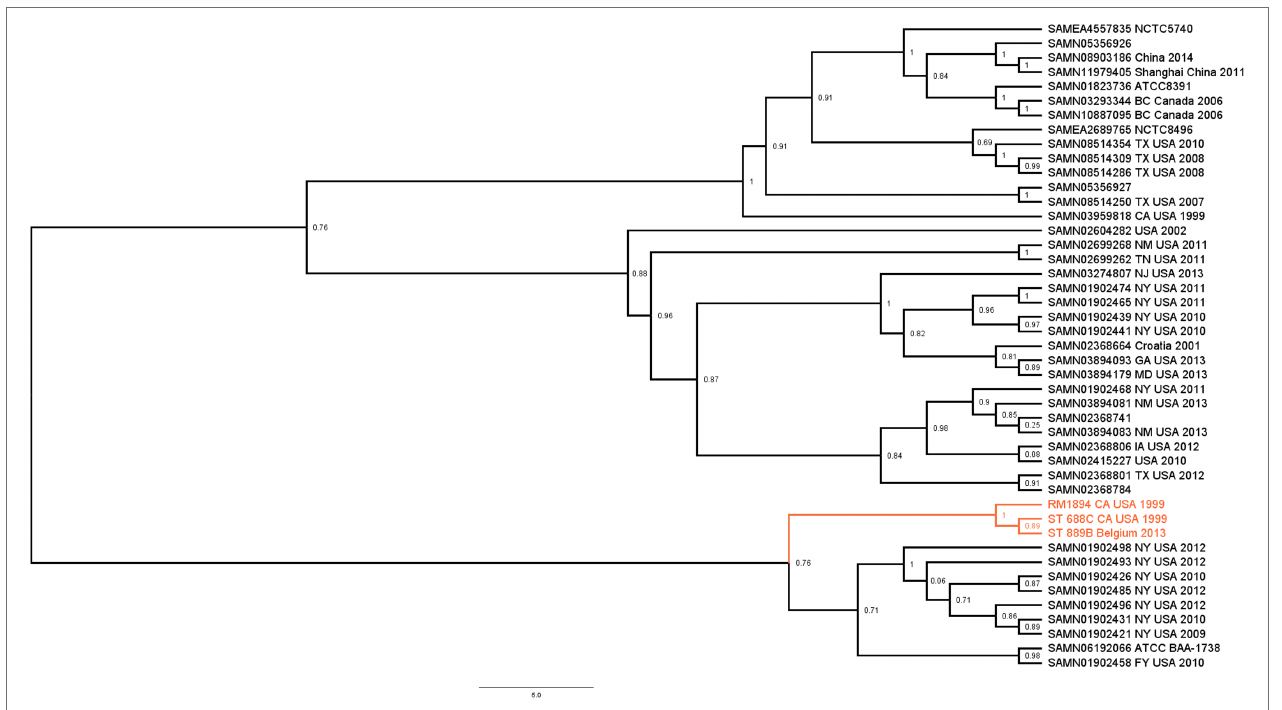
FIGURE 1 | Maximum likelihood SNP tree illustrating the phylogenetic relationship between ST 688C, ST 889B, the 1999 California coriander outbreak clinical strain RM1984 (three isolates of interest highlighted in color) and all other publicly available closely related members of S. Thompson isolates. Genomes downloaded from NCBI were denoted with their Biosample accession numbers followed by the place and year of isolation, if available. Numbers denote bootstrap